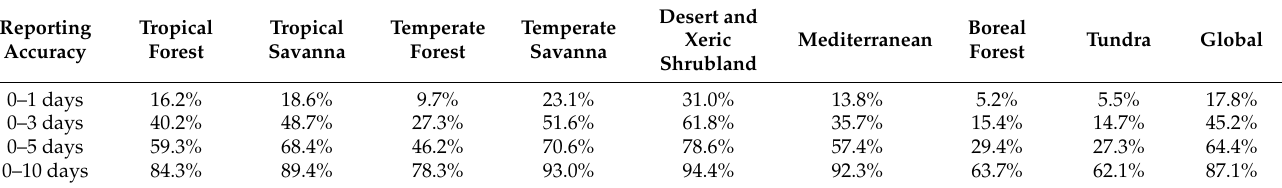
Table A2. Average (2017–2019) temporal reporting accuracies of the FireCCI51.